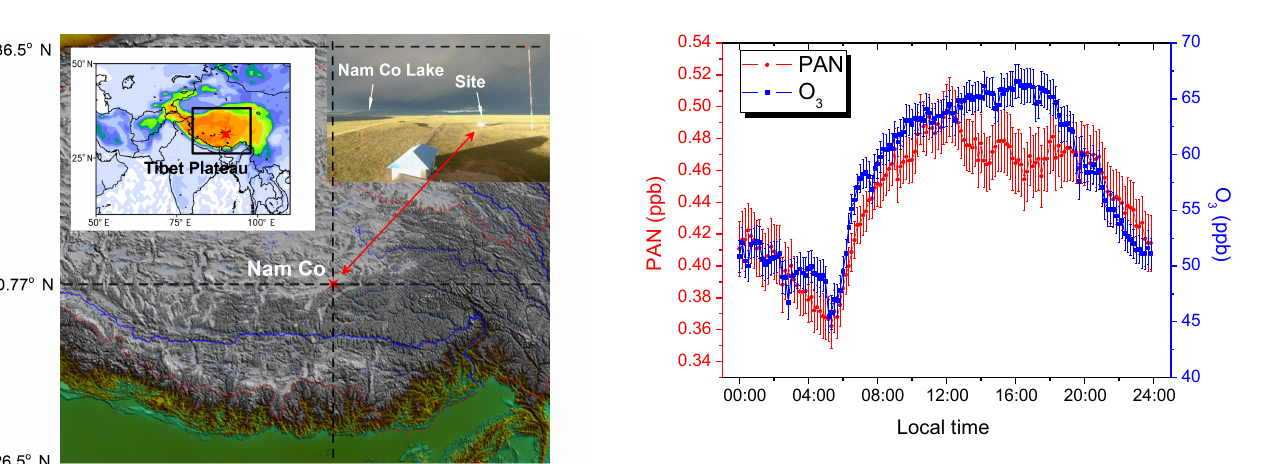
Figure 2. Diurnal patterns of PAN and O 3 . All data are processed as 10min resolution. The vertical bars represent one standard error of the